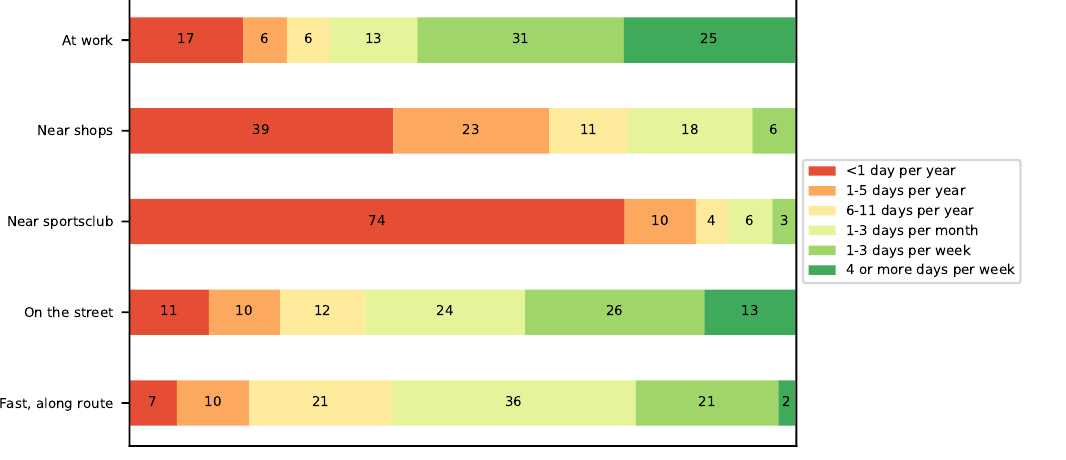
Figure 4. Charging frequencies for several locations